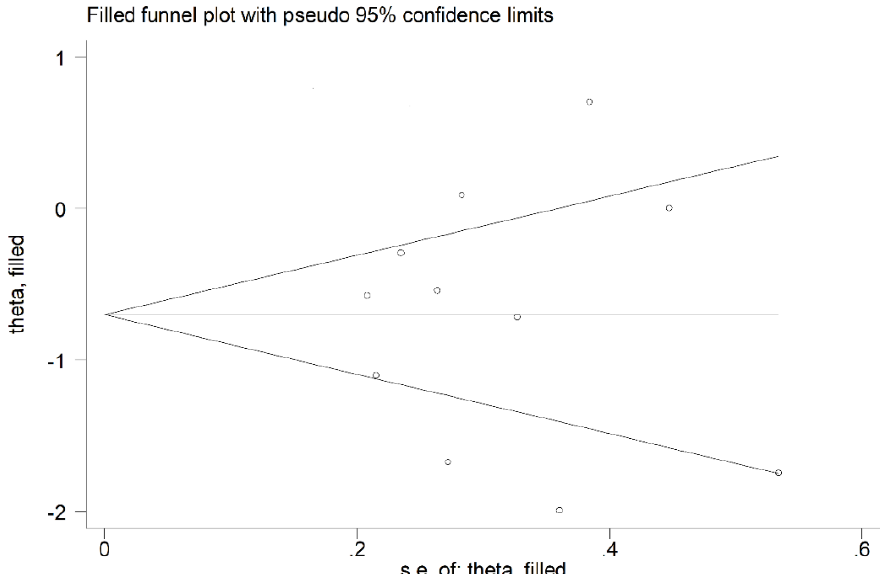
Figure 4. Funnel plot of studies investigating the association between serum PON-1 concentrations and OSA after trimming and filling. The enclosed circles represent the dummy studies, while free circles symbolise the genuine studies.